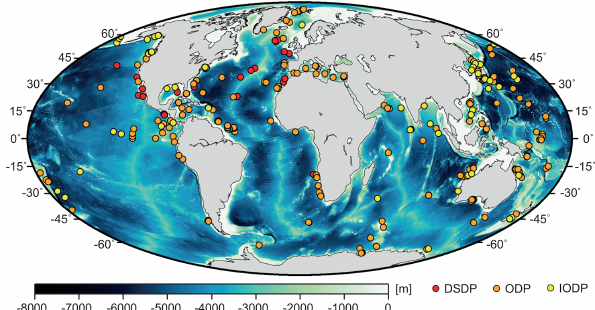
Figure 1. Distribution of the 333 boreholes from which v p (z) pro- files were extracted. DSDP: Deep Sea Drilling Project; ODP: Ocean Drilling Program; IODP: International Ocean Discovery Program. Bathymetry (30s resolution) is from the GEBCO_2014 grid (http: //www.gebco.net, last access: 11 November